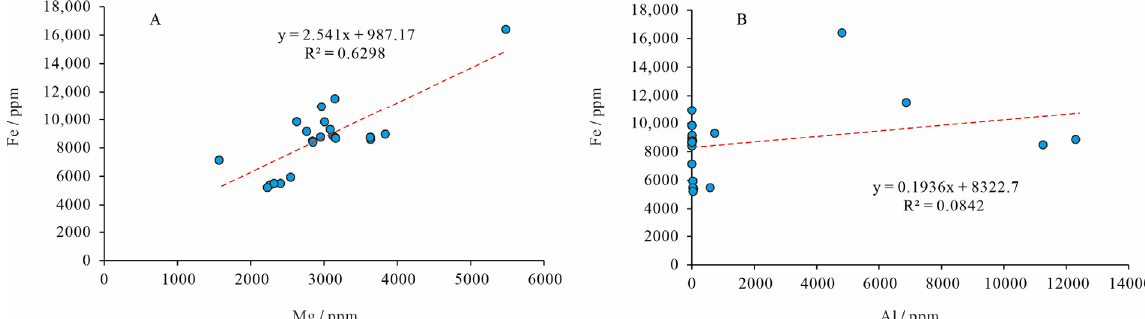
Figure 13. Correlation between the concentrations of Fe and Mg and Al in calcite cements. ( A ) Corre- lation between the concentrations of Fe and Mg. ( B ) Correlation between the concentrations of Fe and Al.